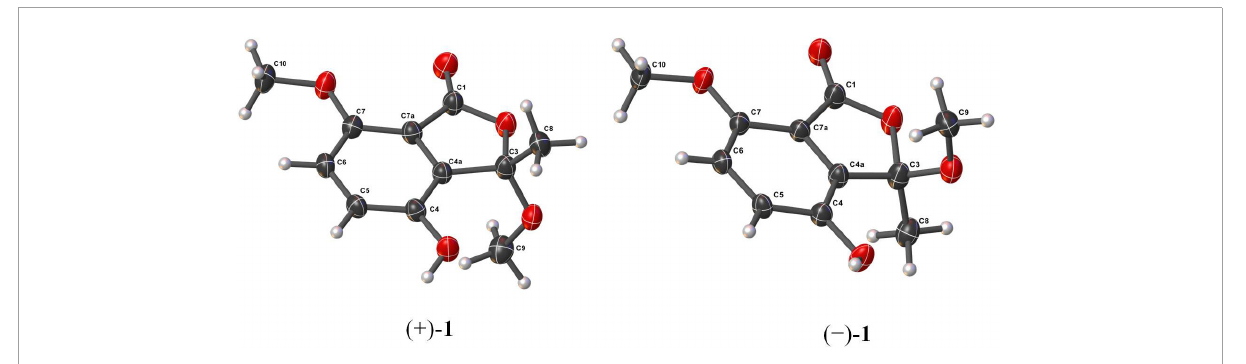
FIGURE3 Molecular structures of (+)- 1 and (–)- 1 from single-crystal X-ray